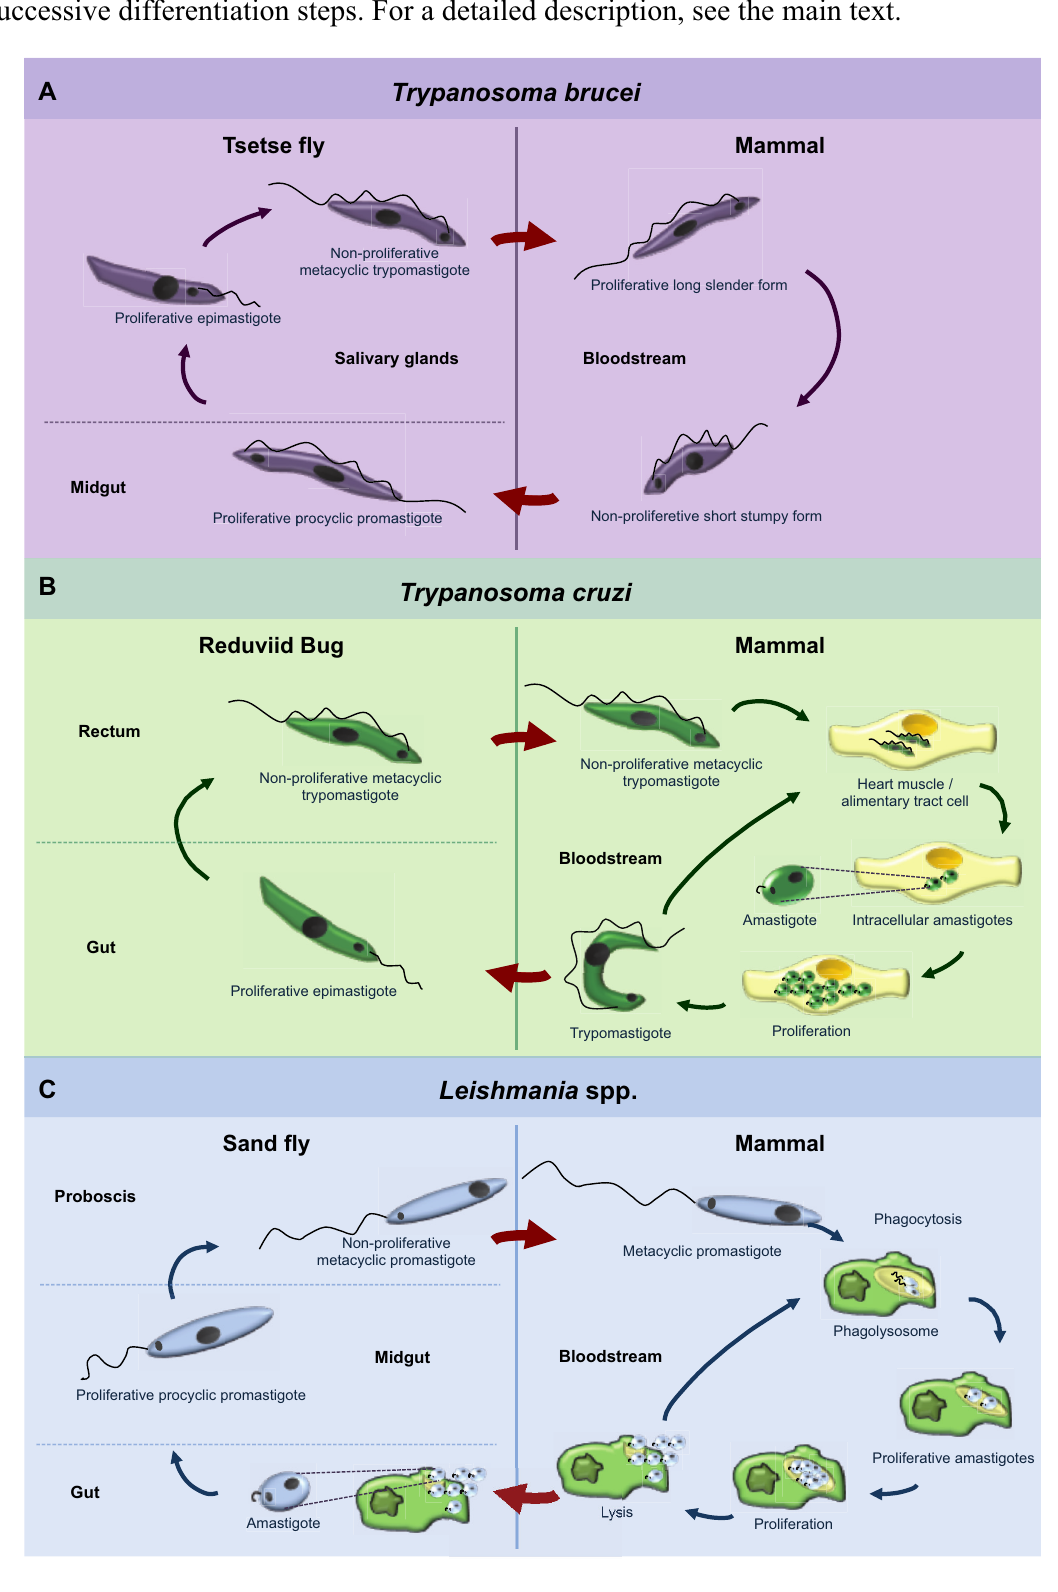
Figure 1. Diagrams of the life cycles of the three trypanosomatid parasites: Trypanosoma brucei ( A ), Trypanosoma cruzi ( B ), Leishmania spp. ( C ). Each of these parasites alternates between an insect host (left hand side of the panels) and a mammalian host (right-hand side). The body parts or cells in which the parasites reside are indicated, as well as the names of the different morphological forms that the parasites display during their successive differentiation steps. For a detailed description, see the main